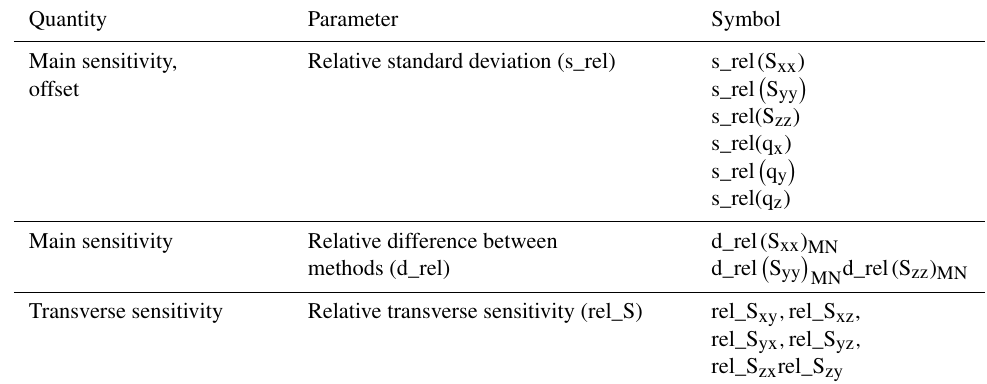
Figure 4. Particulars of the test bench: indication of the directions of acceleration. Piezo-electric (a) and MEMS (b) sensors, mounted on the inclined clamp. Laser vibrometer (c) . Table 2. Parameters used for the